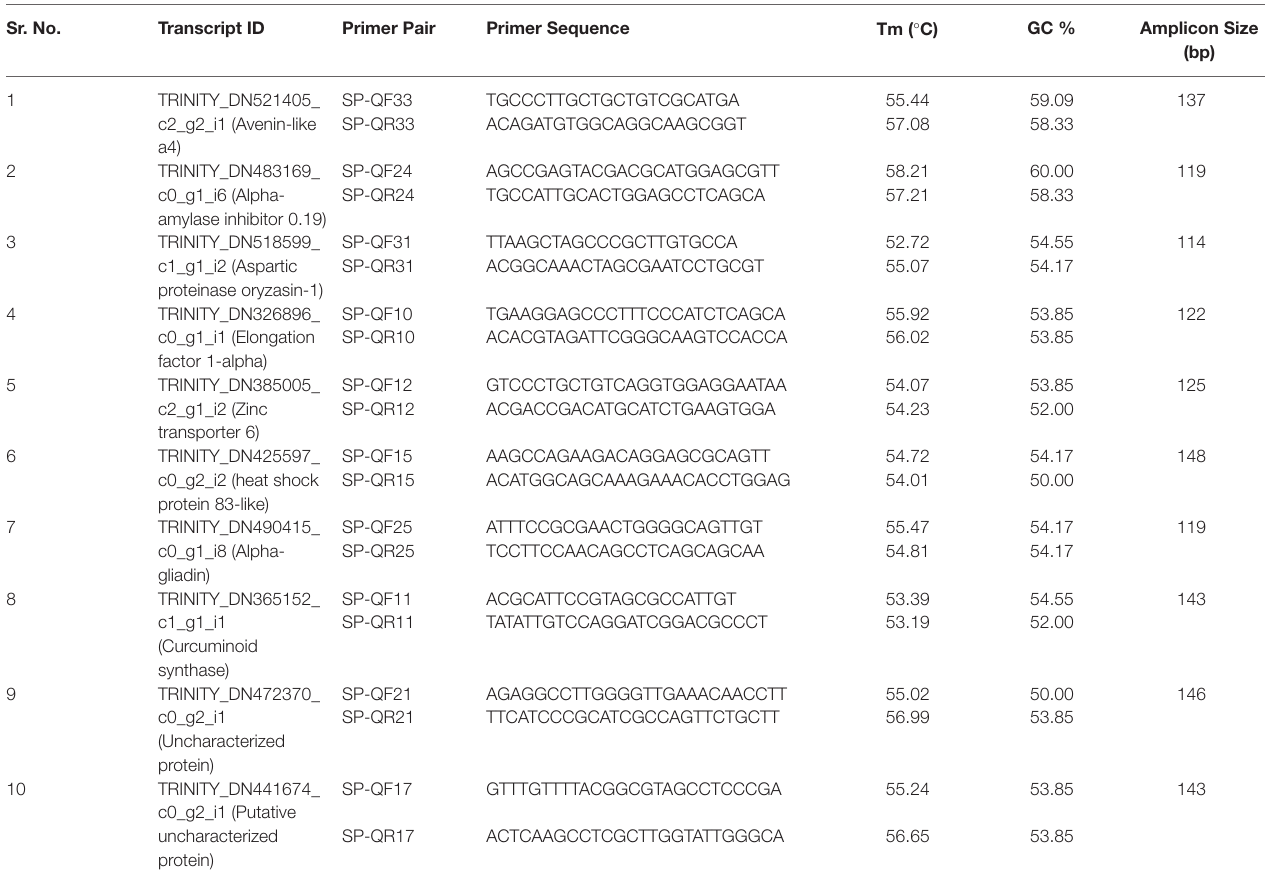
TABLE 5 | Differentially Expressed Transcripts (DETs) and primers used for qPCR. Sr. No.